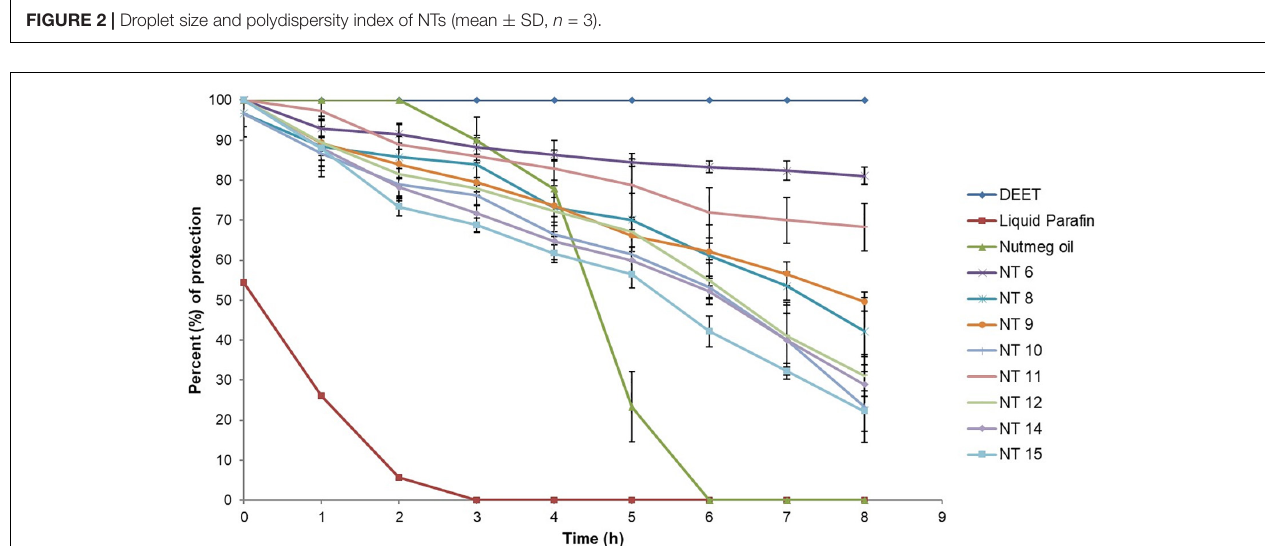
FIGURE 3 | Mosquito repellent activity of controls, nutmeg oil, and selected NTs at hour intervals for the 8 h repellent test (Mean ± SD, n =